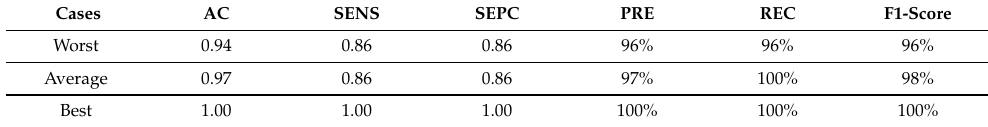
Table 8. AC, SENS, SPEC, PRE, REC and F1-score, for 3 cases worst, average and best